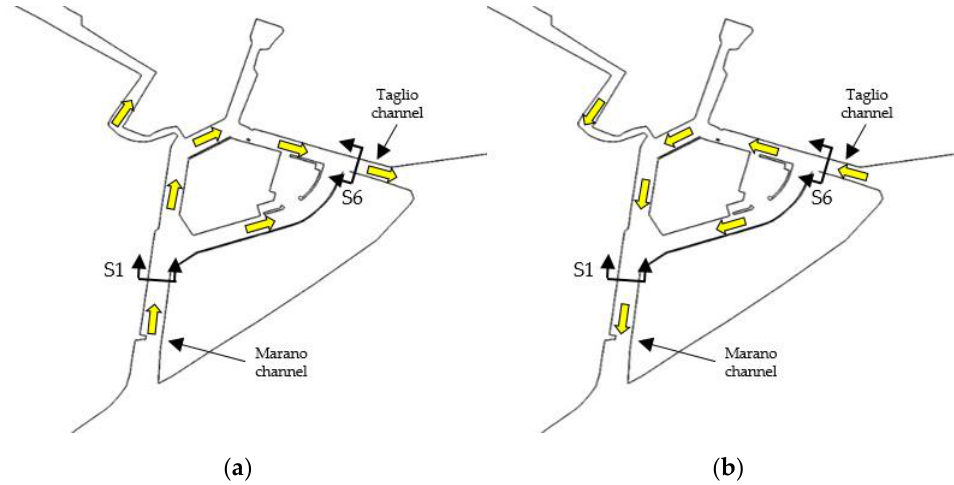
Figure 14. Sketch of the functioning of the Marano port as a hydraulic network during: ( a ) flood tide; ( b ) ebb